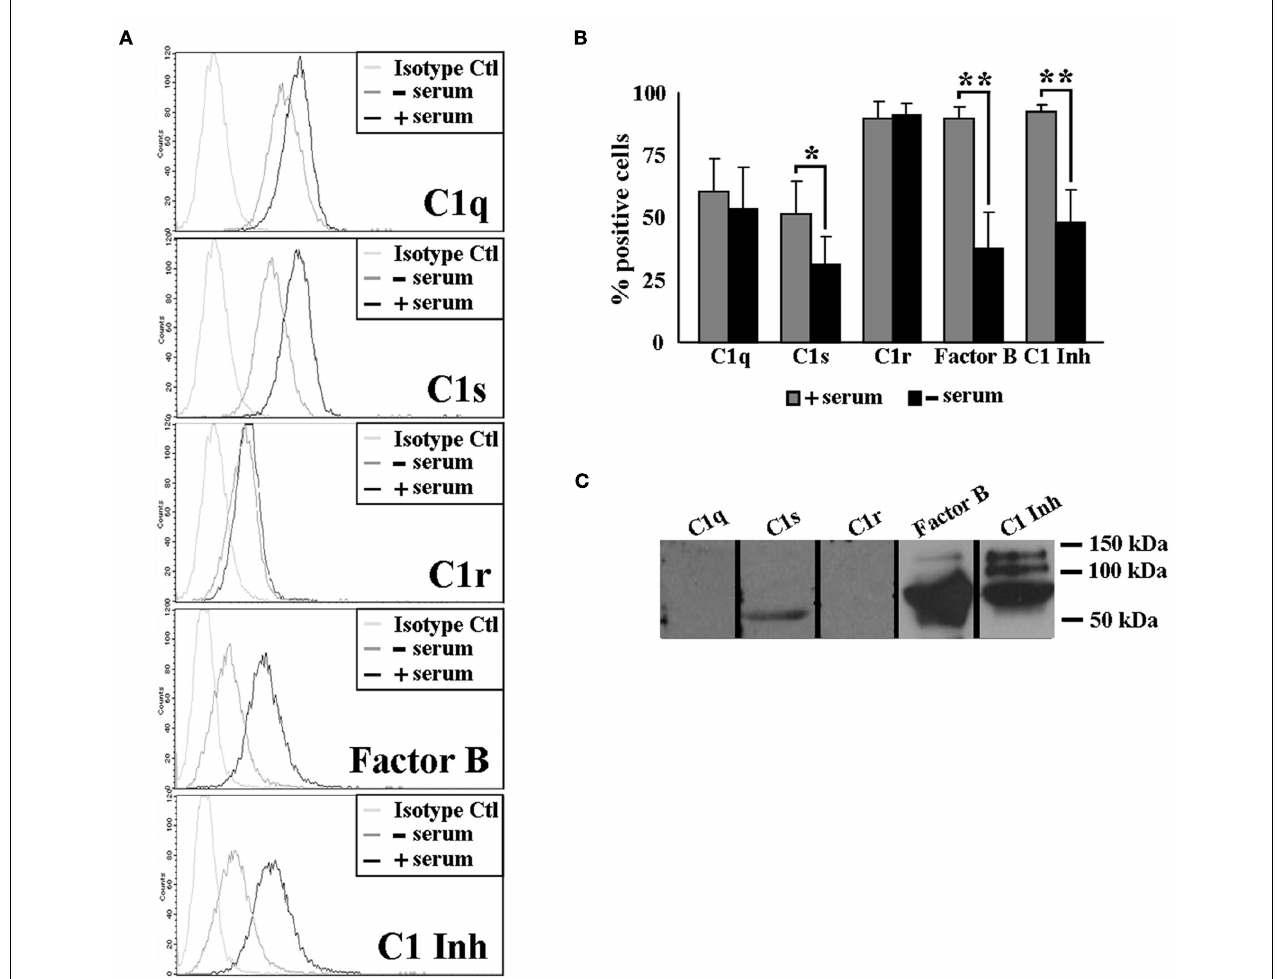
analyzed by flow cytometry. One experiment is shown (A) , representative of three experiments. (B) * p ≤ 0.05; ** p ≤ 0.01 (C) C1 complex components are released into the supernatant of U937 cells. Supernatants of U937 cell cultures were subjected to SDS-PAGE and subsequently visualized by Western blotting using the same primary Abs as above, followed by HRP-conjugated secondary Abs ( n =